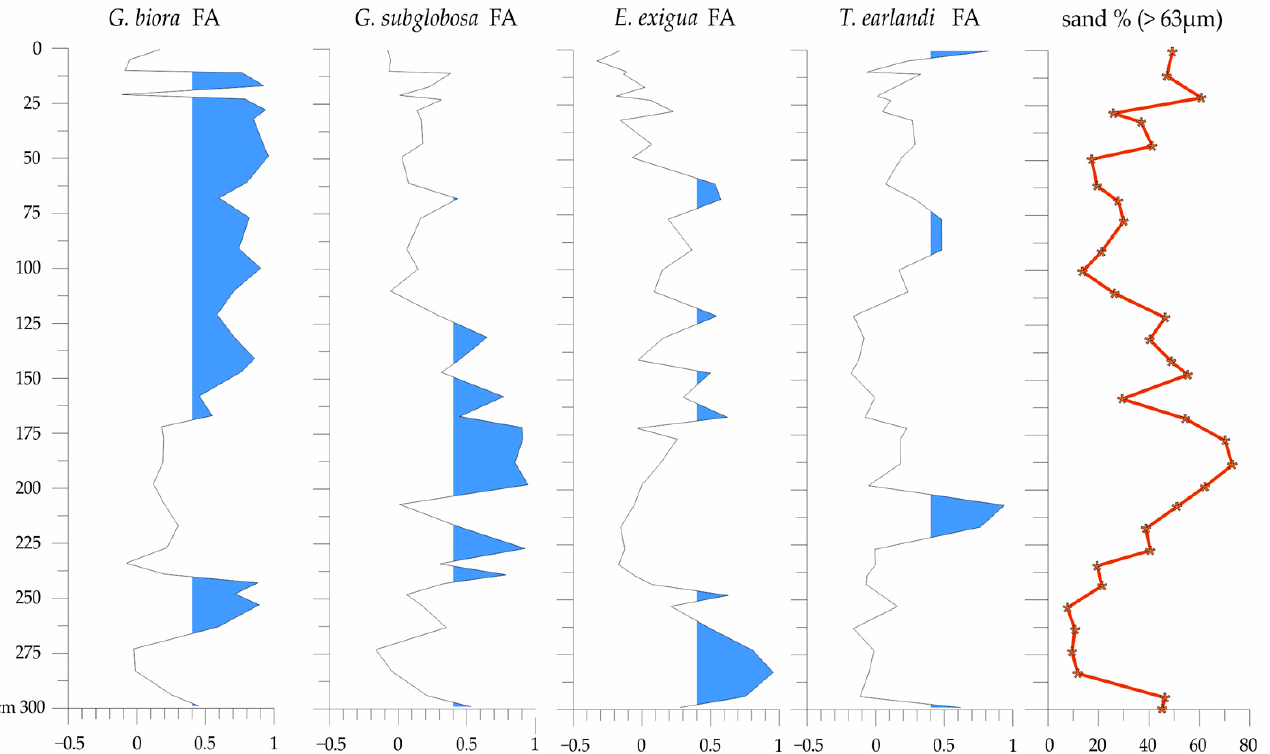
Figure 4. Down-core distribution of the foraminiferal assemblages (FAs) calculated by the principal component analysis (statistically significant loadings as suggested by [77] are shown in blue), together with the percentage of sand in the sediments.